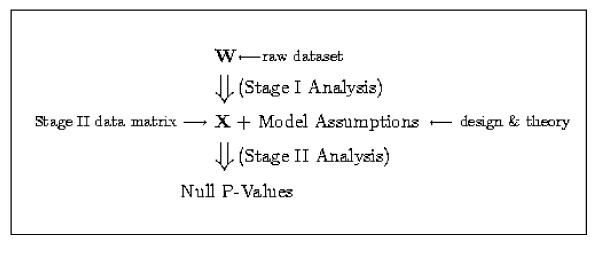
A two-stage procedure was used to obtain the sets of null p-values referenced in [1] and [2]. The first stage of the procedure involves the application of algorithms designed to correct and normalize the raw data matrix, W. The second stage of the procedure involves the evaluation of a test statistic for differential expression using information from the Stage II data matrix, X. [1] considered 150+ unique combinations of algorithms and input parameter values for the Stage I analysis and proposed a subset of the 10 best. [2] determined that the distributions of the null p-values for the [1] 10 best Stage I analyses were non-uniform for the most common choices for the Stage II analysis (e.g., t-test, permutation t-test, and Wilcoxon Rank Sum test). [2] concluded that this non-uniformity implies that the technical replicates generated by the experiment do not constitute adequate approximations of biological replicates and hence, the Stage II model assumptions associated with these tests are not met. We provide evidence that the non-uniformity can be attributed, at least in part, to the failure of the Stage I analyses to correct for systematic biases in the raw data matrix, W.